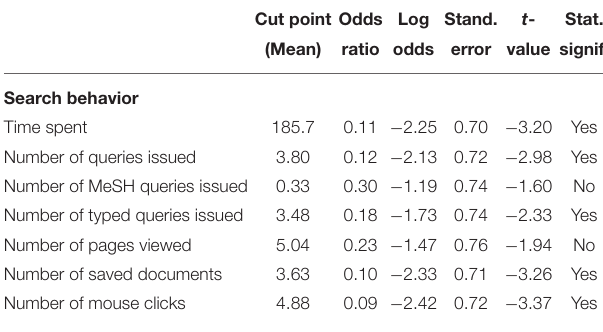
TABLE 2 | Summary of the relationship between search task difficulty and search behavior (N search task difficulty = 256, N eye gaze = 256; statistical significance at 95%).